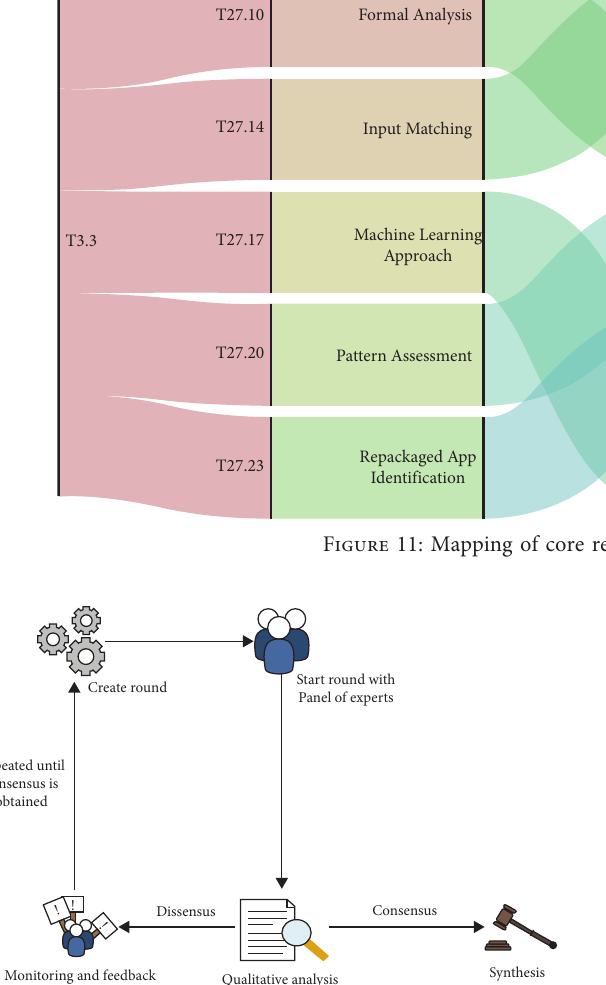
Figure 12: Working flow of the Delphi method.